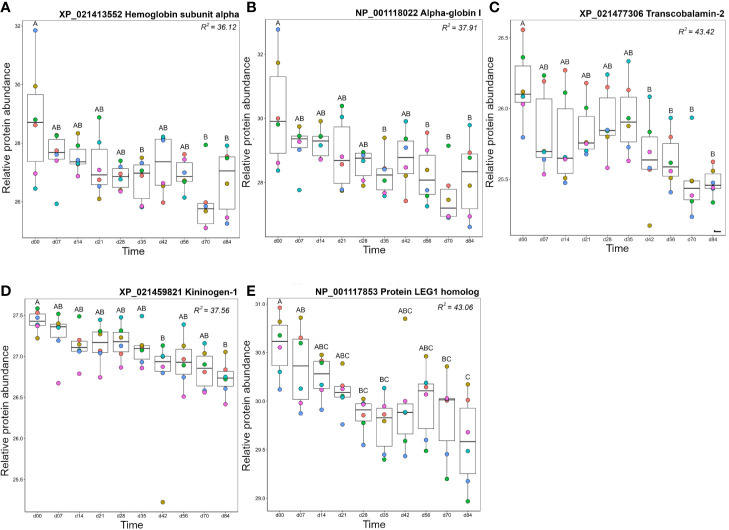
Proteins in Cluster B3 (Figure 3); (A) hemoglobin subunit alpha, (B) alpha-globin I, (C) transcobalamin-2, (D) kininogen-1, and (E) protein LEG1 homolog. Other details are as in the Figure 4 legend.